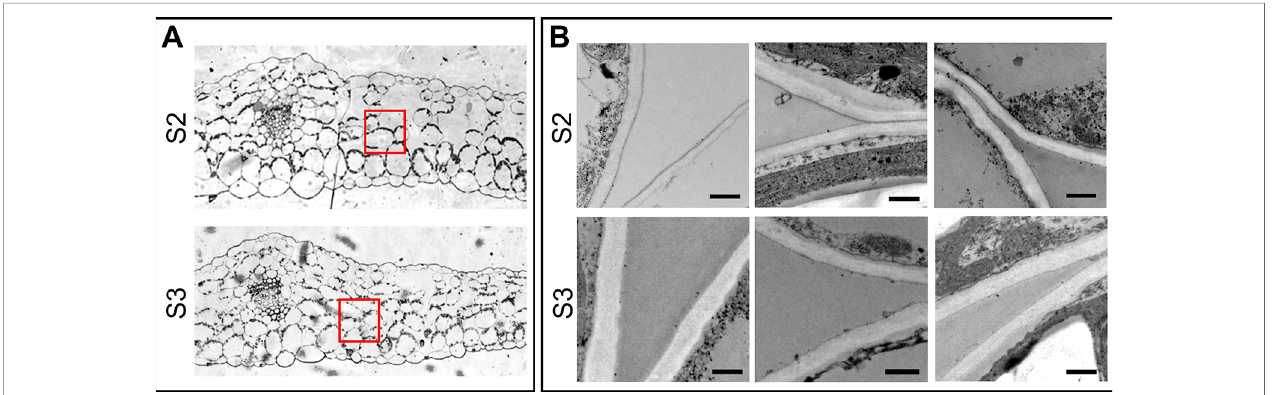
FIGURE 3 | Cell wall thickness of spongy mesophyll cells. (A) Transverse section of the middle part of the leaf, showing the areas examined for cell wall thickness. (B) Electron microscopy of the selected areas in panel A . Upper panel: S2 leaves, lower panel: S3 leaves. Scale bar 500 nm. Cell wall thickness was examined in different cells of at least three different leaves of each Stage. Measurements were taken at different points on the images, the number of total measurements for S2 and S3 were: n = 639 and n = 739, respectively. Obtained values were analyzed by one-way ANOVA, and Univariate Tests of Signi fi cance: n (S2 = 639, S3 = 739), mean ± SEM (S2 = 247.9 ± 3.0 nm, S3 = 278.8 ± 2.9), F = 63.02, P ≤